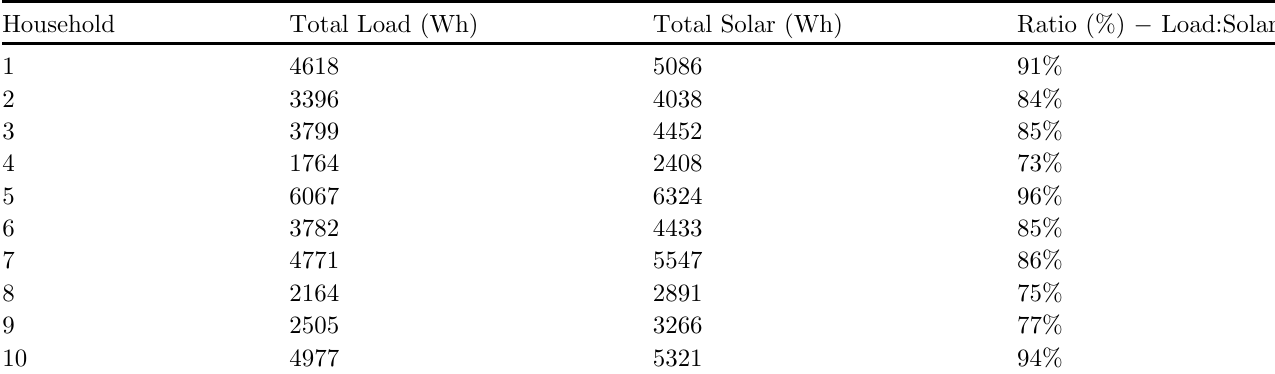
Table 3. The ratio of Load:Solar (%) for ten urban households (26th Nov to 17th Dec 2020).